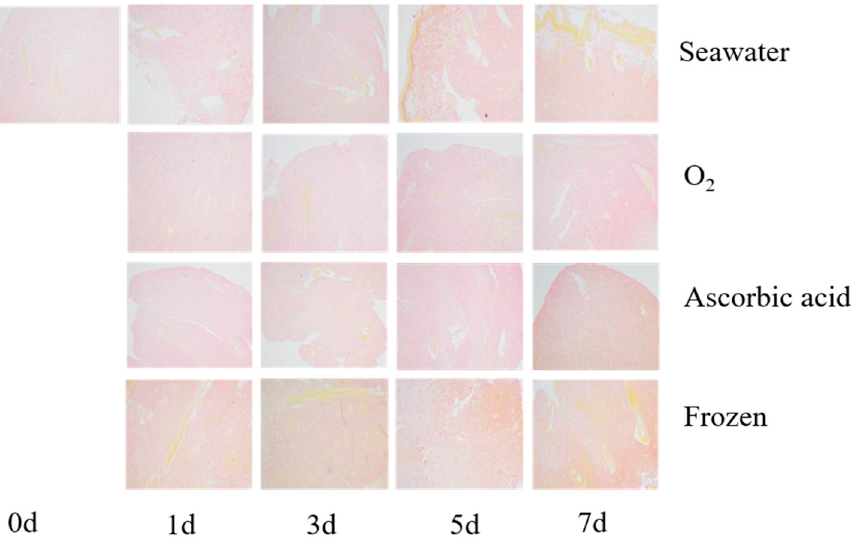
Figure 3. The tissue slice of boiled sea cucumber after storage with different methods for 7 days. The slice was stained by V-G staining (100×).